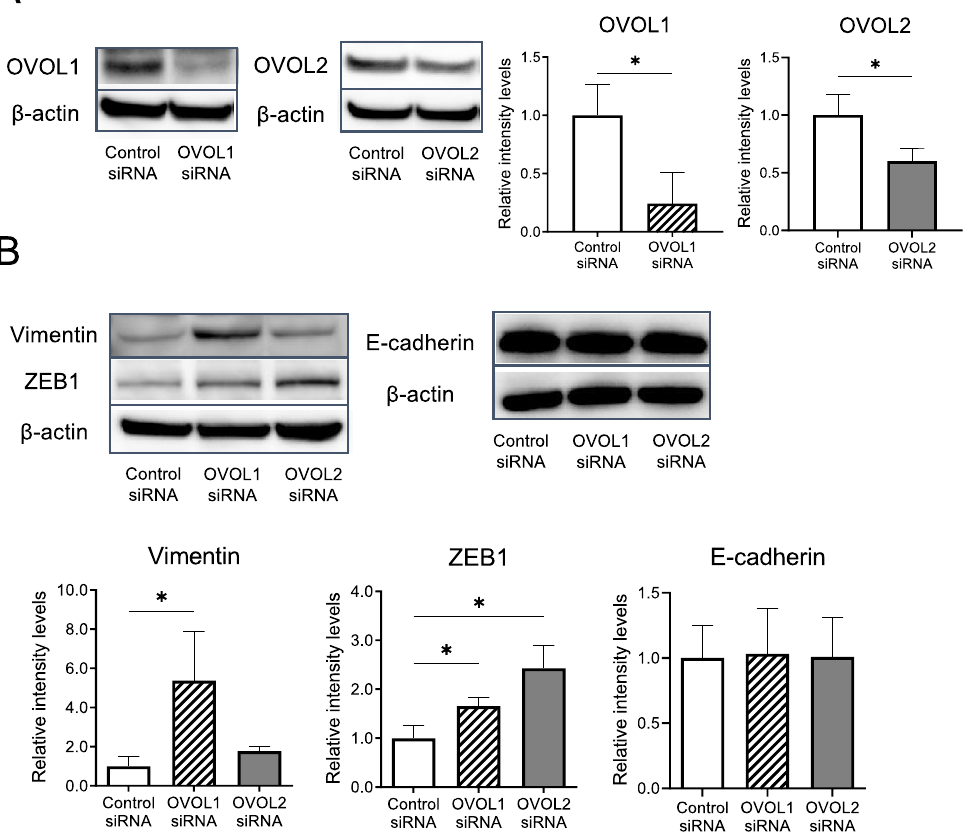
Figure 4. Vimentin and ZEB1 protein levels are regulated by OVOL1 and OVOL2 in a human SCC cell line. ( A ) Relative protein expression levels of OVOL1 and OVOL2 in A431 cells treated with control siRNA, OVOL1 siRNA, or OVOL2 siRNA for 48 h. (Left) Representative blot images and (right) relative expression levels calculated from three independent experiments. ( B ) Relative protein expression levels of vimentin, ZEB1, and E-cadherin in A431 cells treated with control siRNA, OVOL1 siRNA, or OVOL2 siRNA for 72 h. (Upper) representative blot images and (lower) relative protein expression levels calculated from three independent experiments. Mann–Whitney U -test; error bars represent mean ± standard deviation. Protein expressions are relative to those of β -actin as a reference. The control siRNA value was set to 1. p -values < 0.05 were assumed to indicate a statistically significant di ff erence; * p < 0.05.